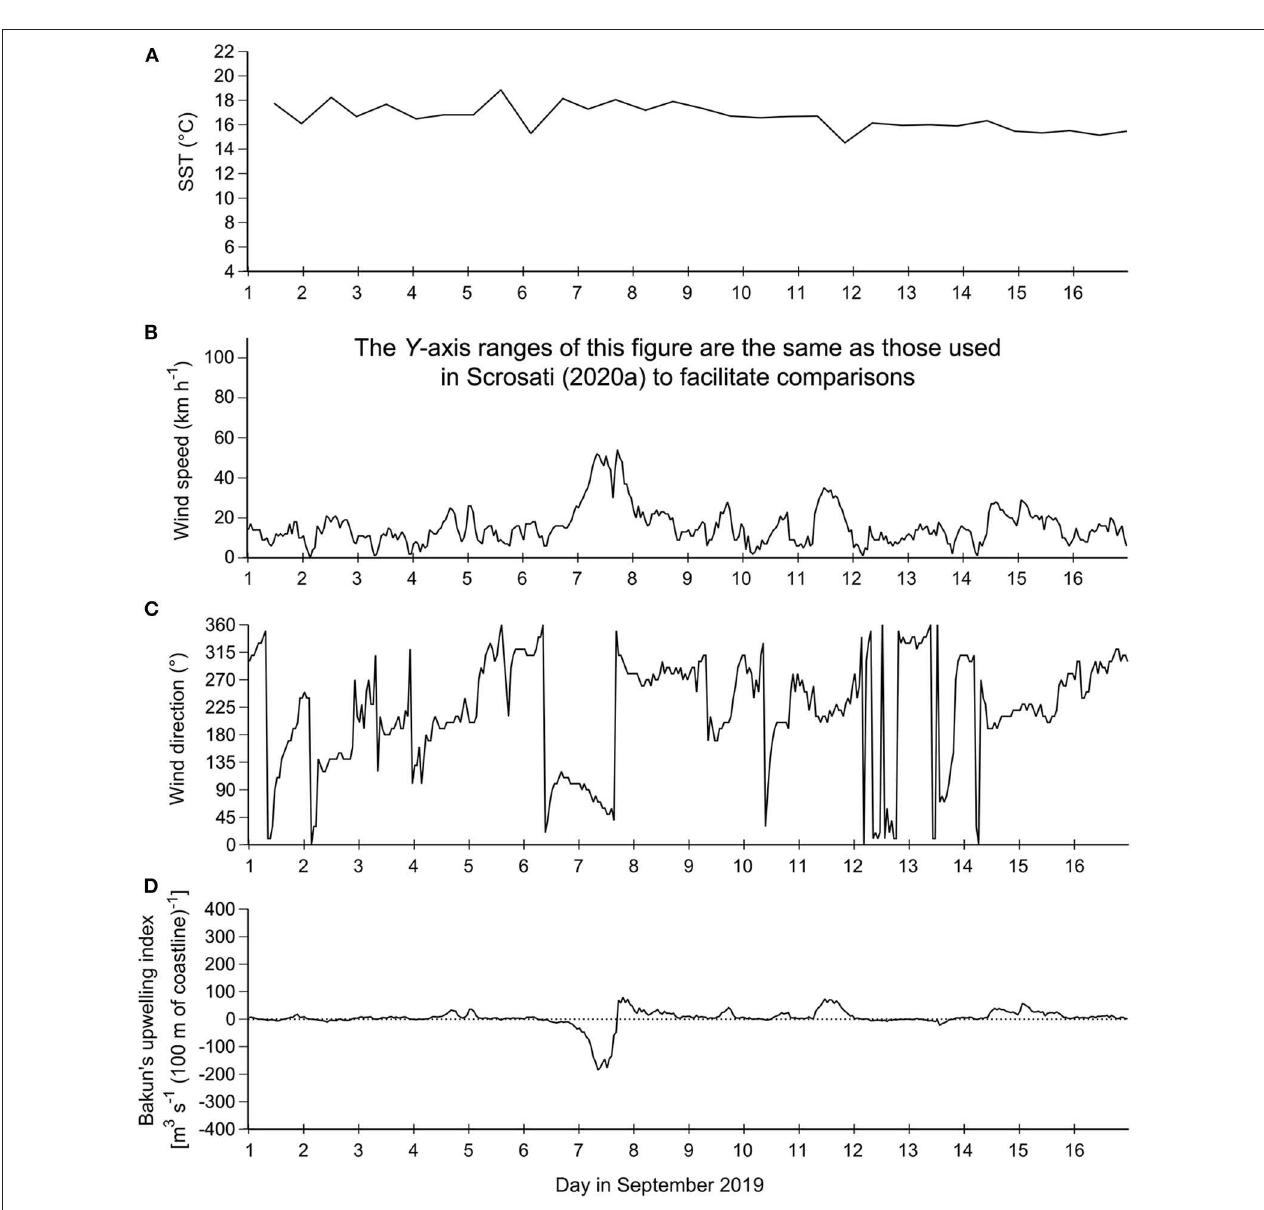
FIGURE 2 | Temporal changes in (A) sea surface temperature (SST), (B) wind speed, (C) wind direction (angle measured clockwise from the north − 0 ◦ − indicating the direction where the wind came from), and (D) Bakun’s upwelling index between 1 and 16 September 2019 at Western Head. The range of values in the four Y axes are the same as those used in Scrosati (2020a) to facilitate visual comparisons with that study. In the X axes, the daily tick marks are placed at the beginning of each day.